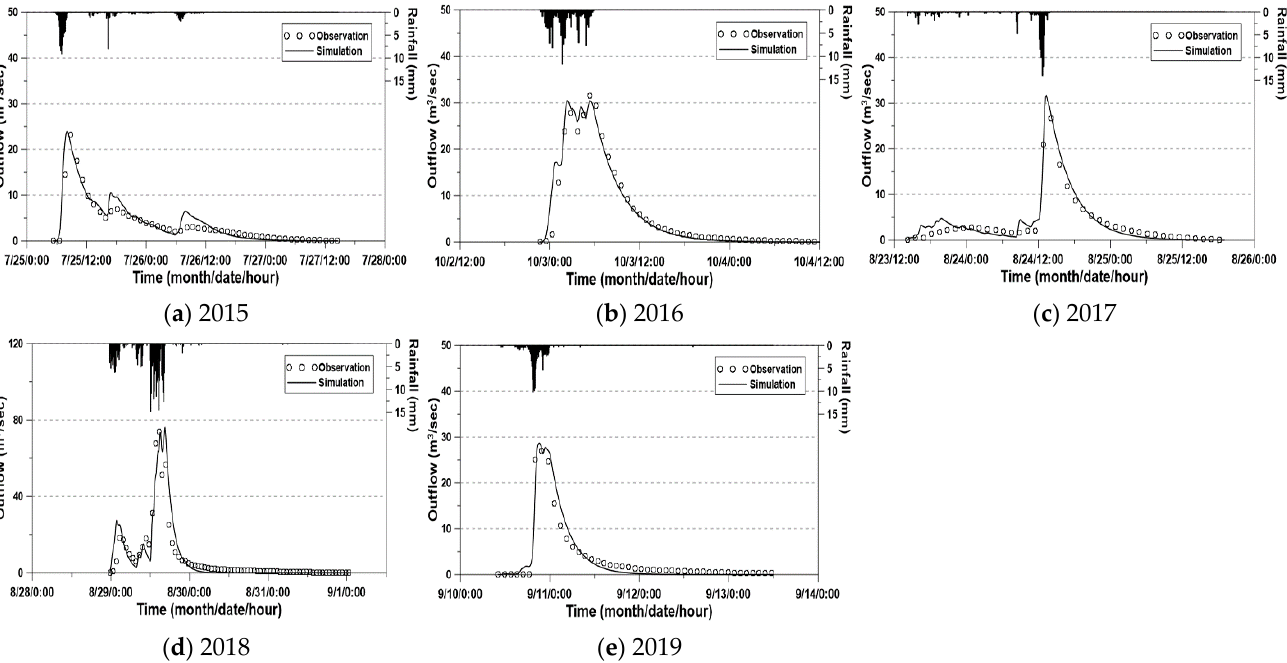
Table 3. Comparison of channel velocity ( V c ), hillslope velocity ( V h ), their ratio m , and concentration time ( T c ) estimated for each rainfall-runoff event.